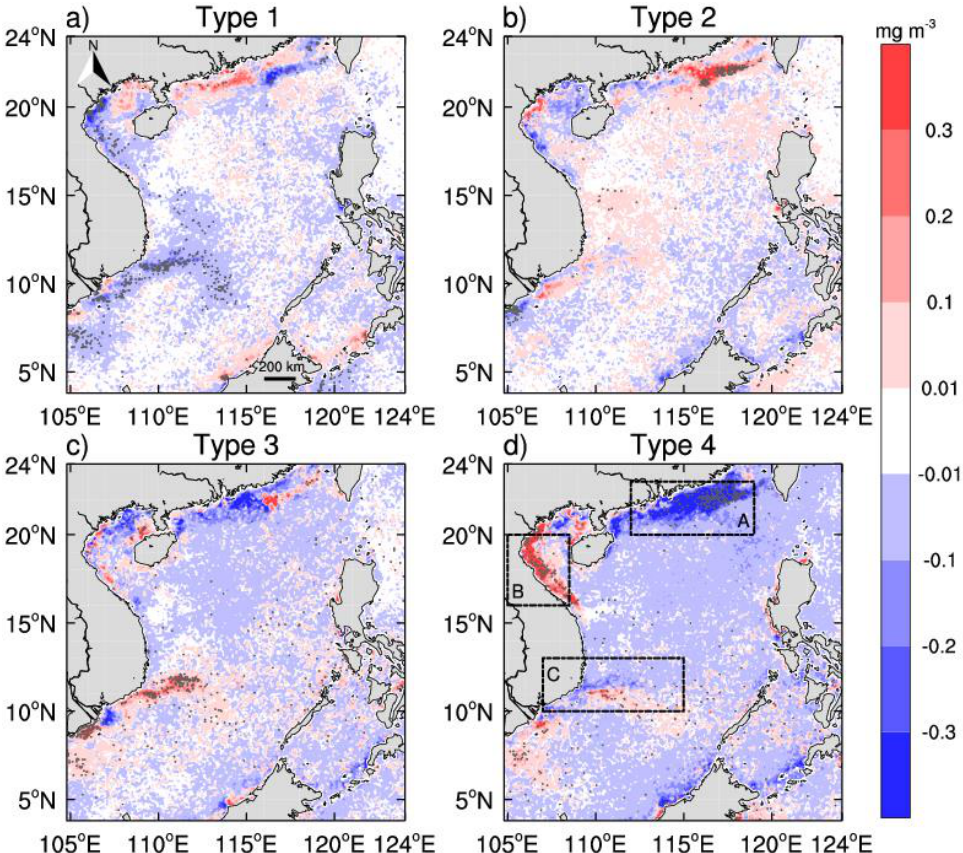
Figure 3. Chl-a concentration anomaly under the four synoptic types (the gray dots cover areas with significant differences): ( a ) Type 1; ( b ) Type 2; ( c ) Type 3; ( d ) Type 4.